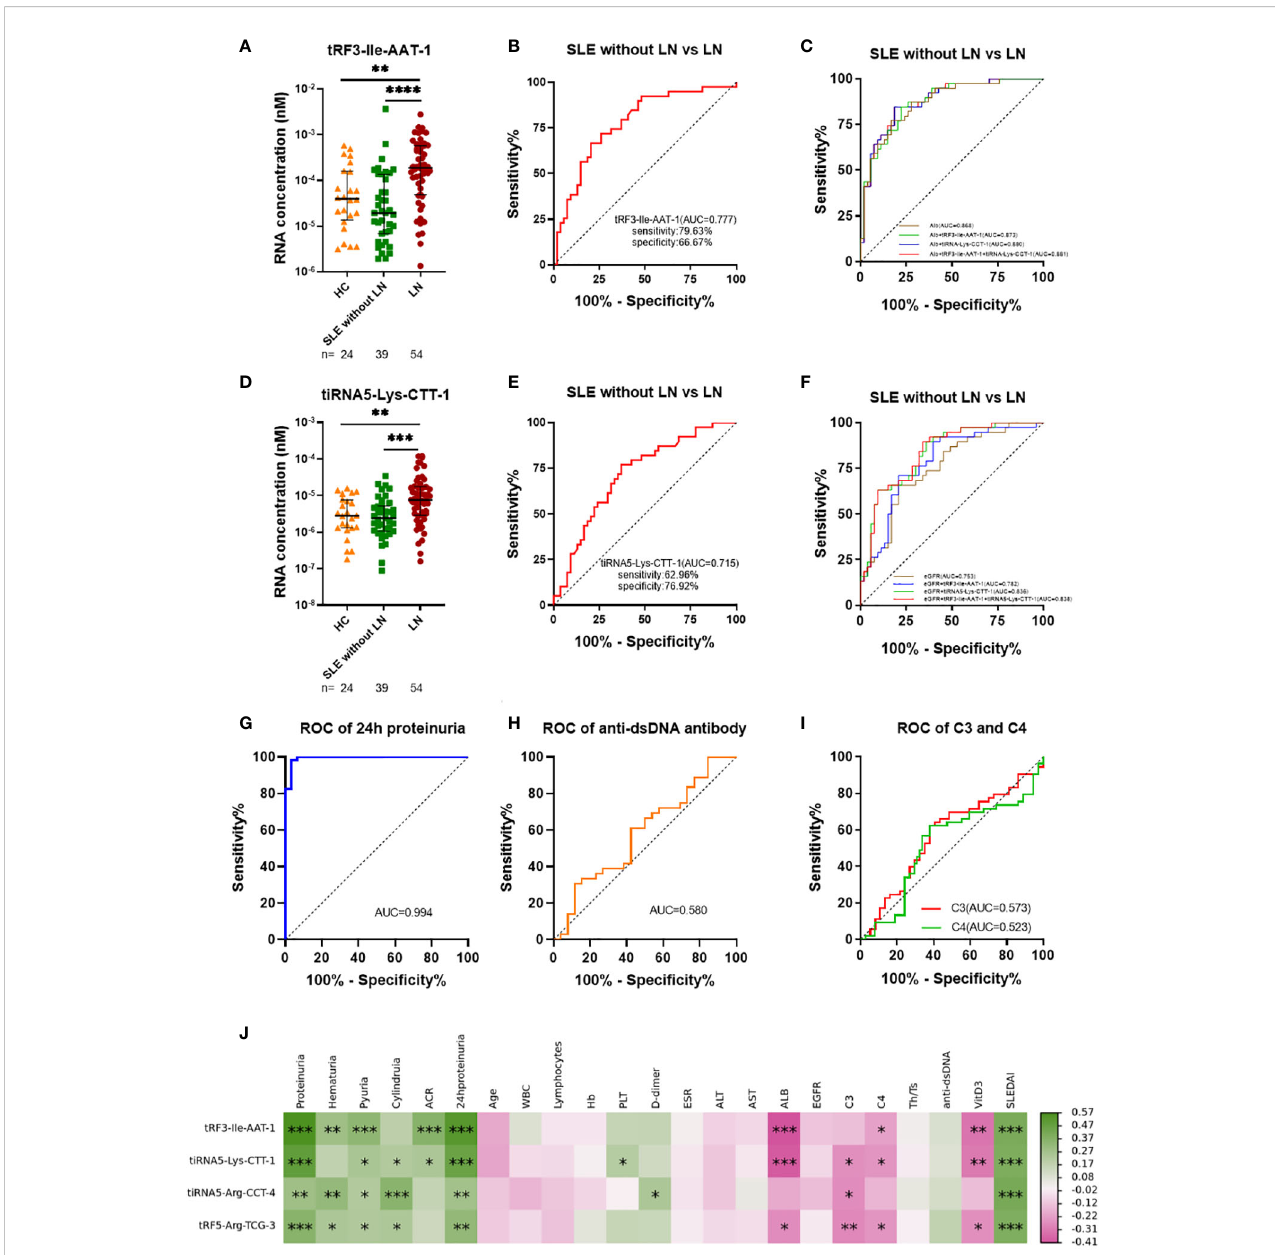
FIGURE 5 Diagnostic value of urinary exosomes derived tsRNAs in the validated stage. (A) Overexpression of tRF3-Ile AAT-1 in LNs compared with SLE without LN patients and healthy controls. (B) Receiver operator characteristic (ROC) curve of tRF3-Ile AAT-1 in distinguishing LNs from SLE without LN patients. (C) ROC combined diagnostic analyses of tRF3-Ile AAT-1and Alb, tiRNA5-Lys-CTT-1 and Alb, as well as tRF3-Ile AAT-1, tiRNA5-Lys-CTT-1 and Alb in discriminating LNs from SLE without LN patients. (D) Overexpression of tiRNA5-Lys-CTT-1 in LNs compared with SLE without LN patients and healthy controls. (E) ROC curve of tiRNA5-Lys-CTT-1 in distinguishing LNs from SLE without LN patients. (F) ROC combined diagnostic analyses of tRF3-Ile AAT- 1and eGFR, tiRNA5-Lys-CTT-1 and eGFR, as well as tRF3-Ile AAT-1, tiRNA5-Lys-CTT-1 and eGFR in discriminating LNs from SLE without LN patients. (G) ROC curve of 24h proteinuria in distinguishing LNs from SLE without LN patients. (H) ROC curve of anti-dsDNA in distinguishing LNs from SLE without LN patients. (I) ROC curves of complement C3 and C4 in distinguishing LNs from SLE without LN patients. (J) Correlation analyses between tsRNAs and clinical variables. Green and red color represent the positive correlation and negative correlation, and the depth of the color represents the degree of correlation. (*P < 0.05, **P < 0.01, ***P < 0.001, ****P < 0.0001)